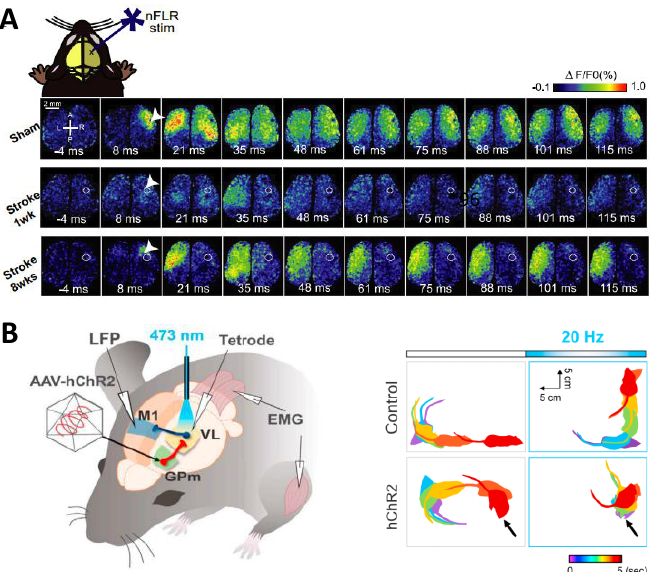
Figure 3. Brain circuit functions in pathological conditions. ( A ) Example of quantitative voltage-sensitive dye (VSD) responses in a bilateral craniotomy preparation after photostimulation of the right (injured) forelimb somatosensory cortex in a sham animal (top), 1 week after stroke (middle), and 8 weeks after stroke animal (bottom). The white circle indicates the lesion in the stroke animals. White arrows indicate laser photostimulation target. Adapted from [46]. ( B ) Left: Lepresentative scheme for photostimulation of GPm-VL synapses and recording activities from VL neurons and body muscles. Right: Representative time series of video frames 5 s before (white rectangle) and during (blue rectangle) photostimulation of the GPm-VL. Adapted from [98] with permission from Elsevier.